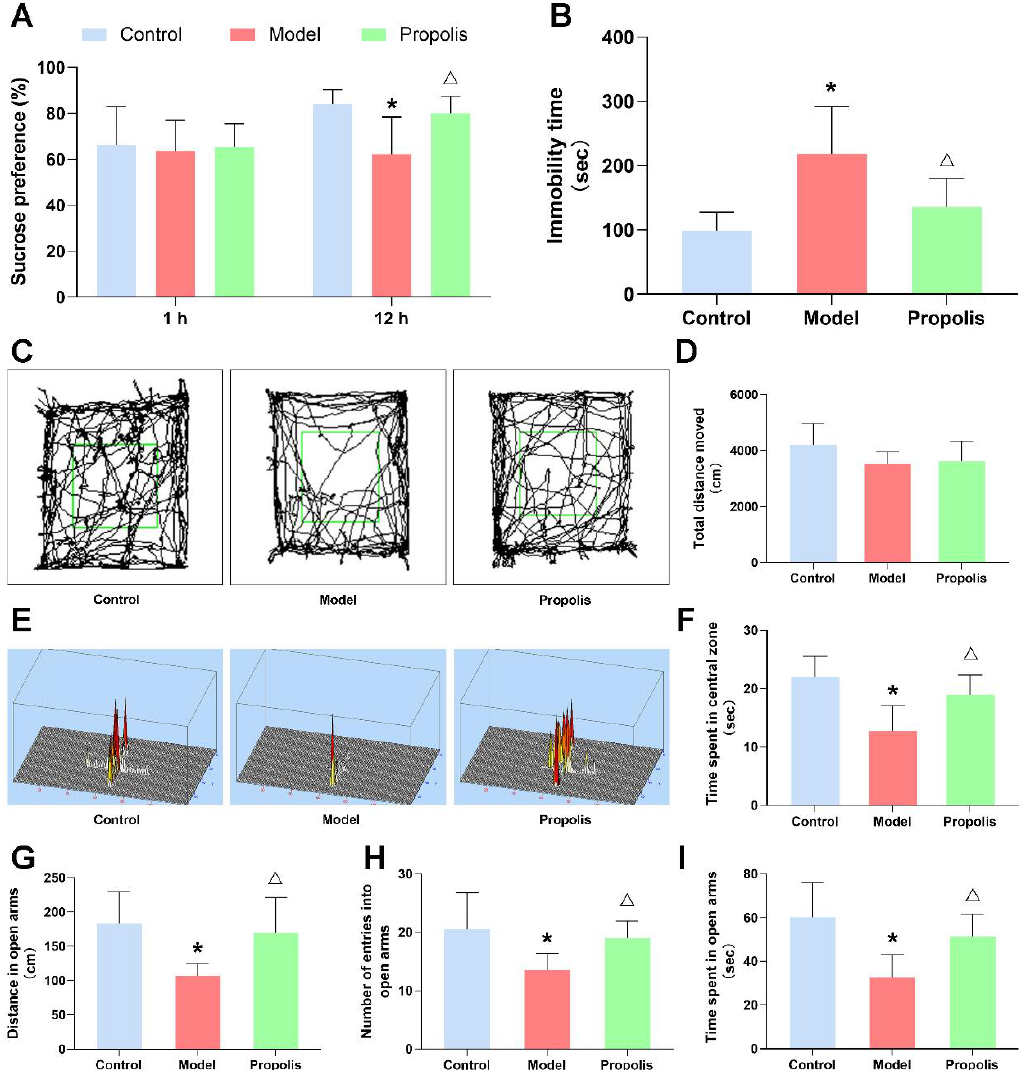
Figure 2. The behavioral performance of mice. ( A ) Sucrose preference of the mice in the different groups. ( B ) Immobility time in the FST. ( C ) Representative animal track in the OFT. Green square area represents the central zone. ( D ) Total distance of mice moved in the OFT. ( E ) Representative activity heat maps in the EPM. ( F ) The locomotion time in the central zone in the OFT. ( G ) Total distance of mice in the open arms of the EPM. ( H ) The number of entries into the open arms of the EPM. ( I ) The locomotion time in the open arms of the EPM. * Denotes p < 0.05 vs. control group; △ p < 0.05 vs. model group. Table 1. The analysis of denatured cell index (DCI) in HE staining. * Denotes p < 0.05 vs. control group; △ p < 0.05 vs. model group.